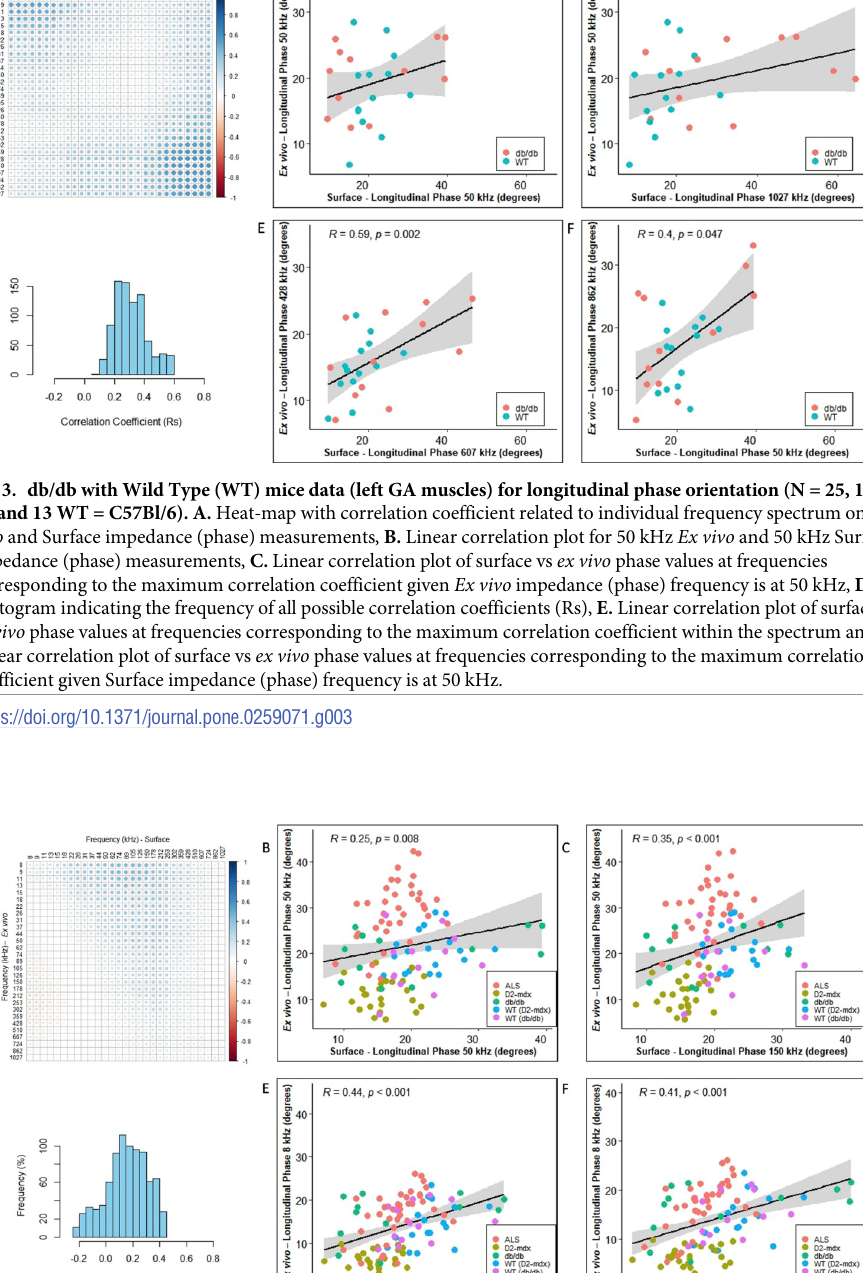
PLOS ONE | https://doi.org/10.1371/journal.pone.0259071 October 29,